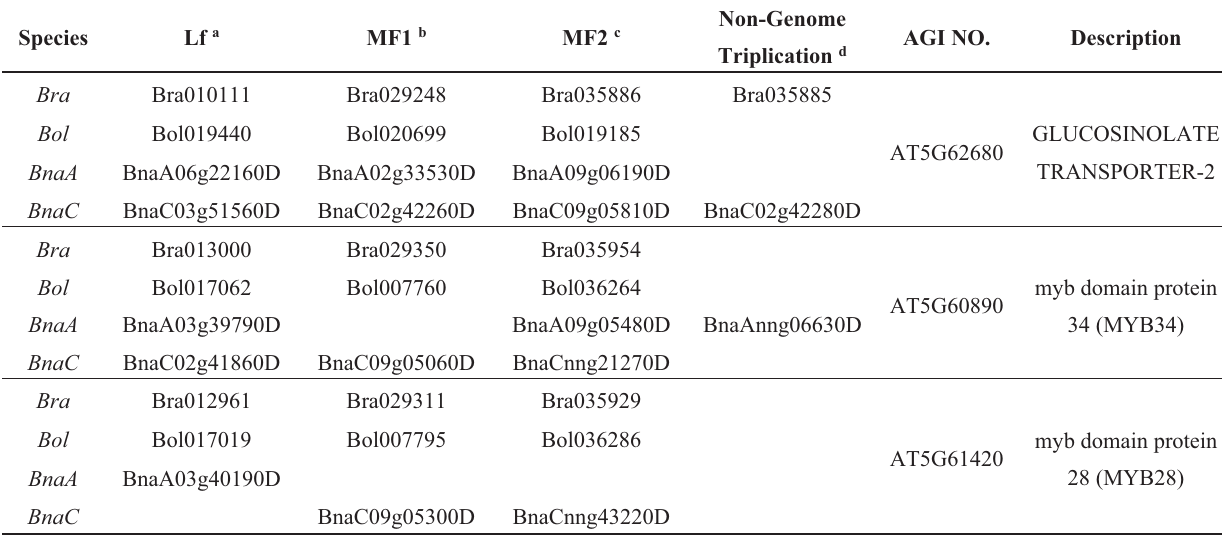
Table 4. The different copies of candidate genes in the B. rapa , B. oleracea and B. napus genome.